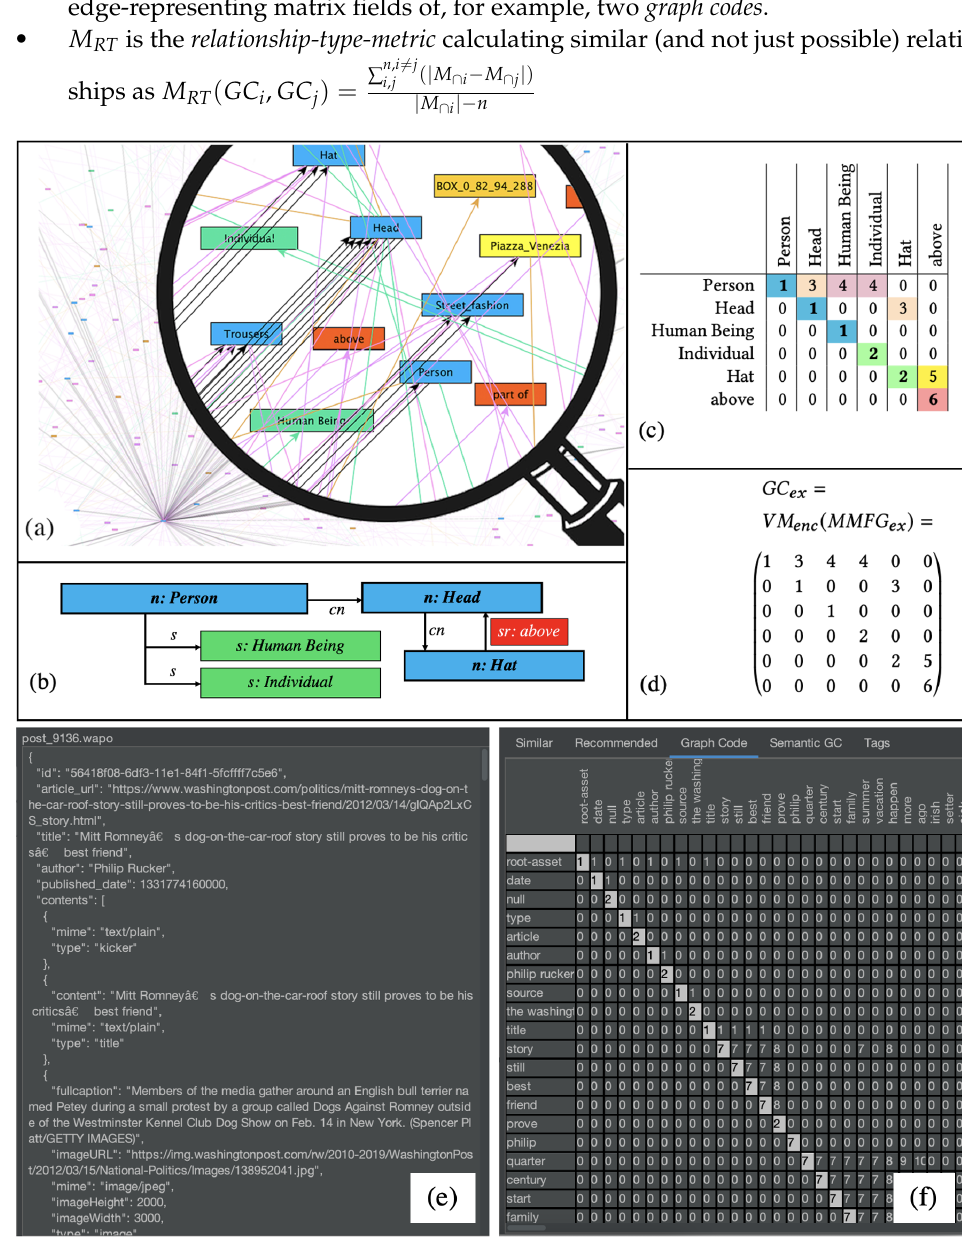
Figure 4. Mutimedia features represented as a graph code index ( a – d ), example of a graph code index and its matrix visualization for a text document ( e , f